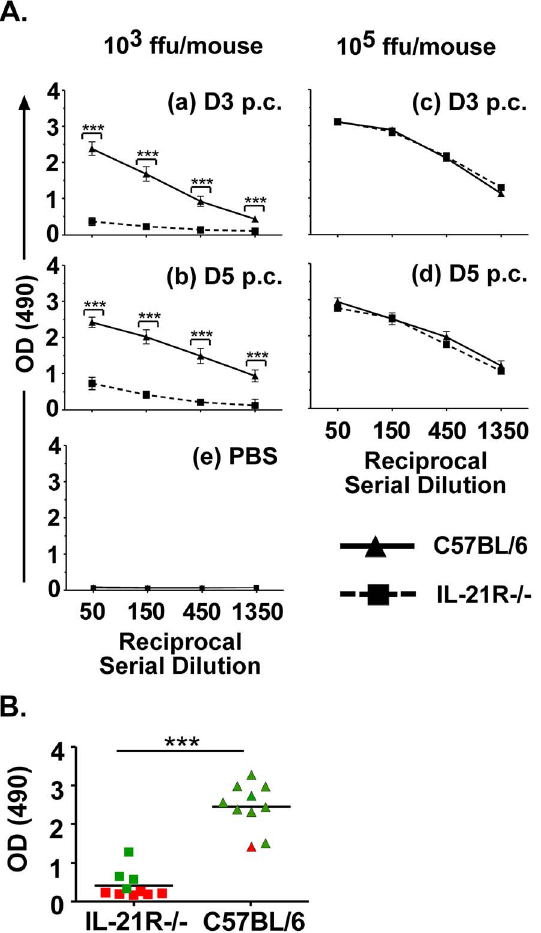
Figure 2. IL-21 signaling is dispensable for antibody recall responses to secondary RABV challenge. A) Five weeks post- immunization, mice immunized in Figure 1 with 10 3 (left panels a and b) or 10 5 (right panels c and d) ffu/mouse were challenged with 10 5 ffu/ mouse of pathogenic Challenge Virus Strain-N2c and sera analyzed 3 and 5 days post-challenge by ELISA for anti-RABV G antibody recall responses as described in Figure 1. PBS-immunized IL-21R 2 / 2 and wild-type mice were also tested in parallel and a representative ELISA data is shown in panel e. B) Antibody titers for individual mice immunized with 10 3 ffu/mouse rRABV and then challenged [from Figure 2A(b)] are shown to indicate an antibody recall response against RABV G by day 3 post-challenge in a minimum number of IL-21R 2 / 2 mice. Mice that survived challenged are shown with a green icon, mice that did not survive challenge are shown with a red icon. Statistical difference in antibody titers by ELISA between two groups of data was determined using an unpaired, two-tailed t test and data is presented at the mean 6 SEM. *p , 0.05, **p=0.01–0.001, ***p # 0.001. (N=9–11 mice per group from two independent experiments). (p.c.=post- challenge; ffu=focus forming units; OD=optical density).